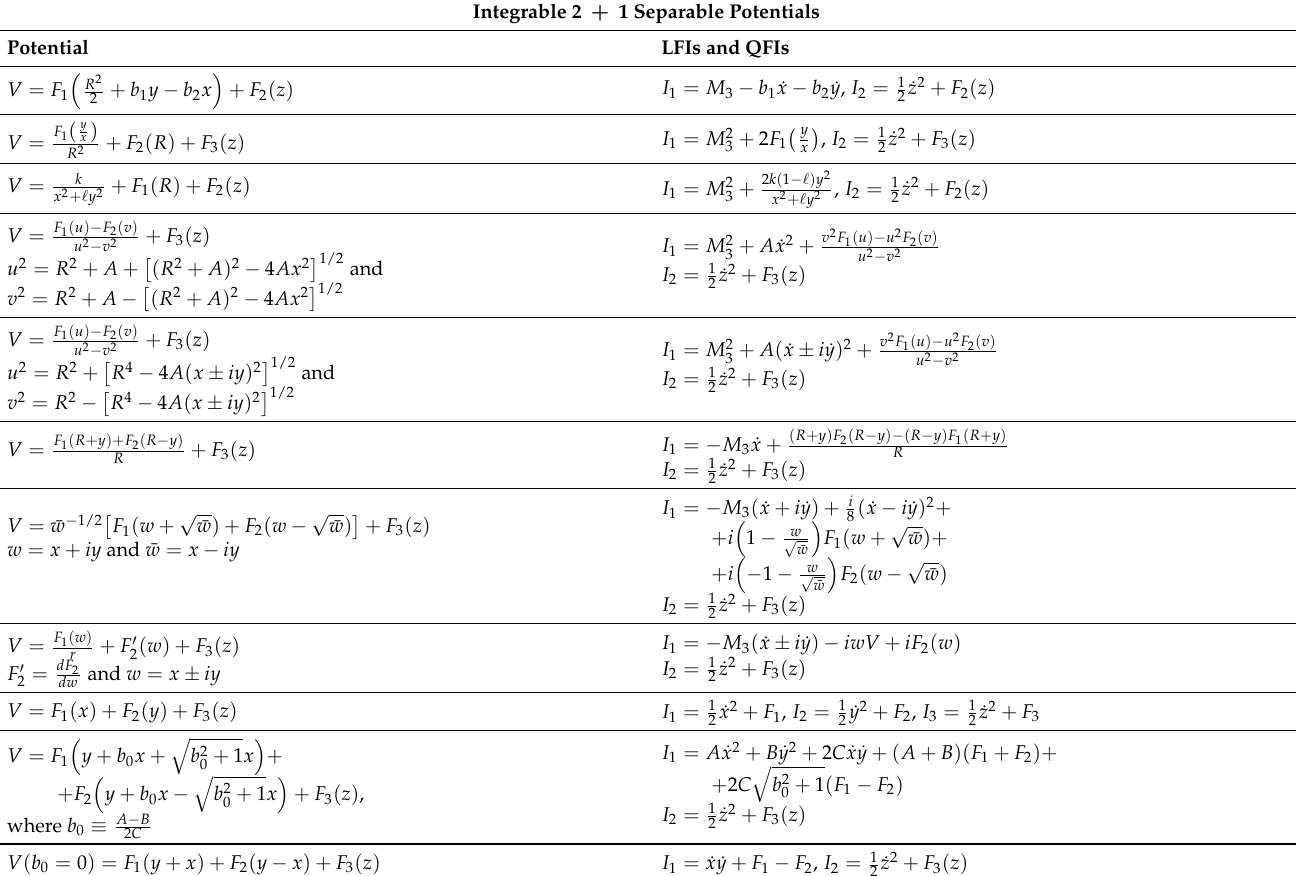
Table 1. Integrable potentials V ( x , y , z ) = Φ ( x , y ) + F ( z ) in E 3 , where Φ ( x , y ) are integrable potentials in E 2 . Integrable 2 + 1 Separable Potentials LFIs and